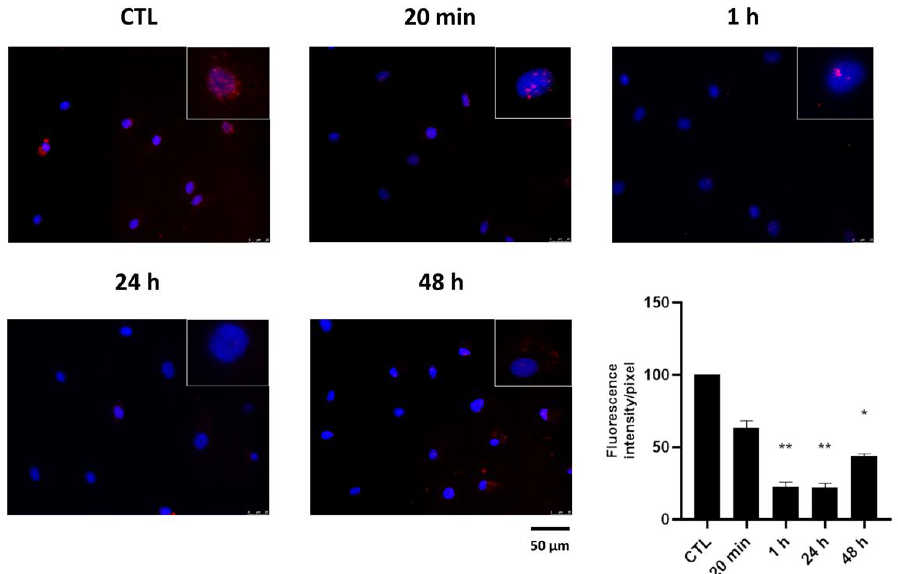
Figure 2. Effects of HPE DMSO extract on PKA phosphorylation. Cells were treated with 0.1 mg/mL HPE DMSO for the reported times and then analyzed by immunofluorescence using anti- p -PKA primary antibody and Alexa Fluor 568 (red) secondary antibody. Nuclei were stained with DAPI (original magnification 40 × ). The bar graph represents the pixel intensities in the region of interest, obtained by ImageJ. * p < 0.05; ** p < 0.01 vs. CTL.